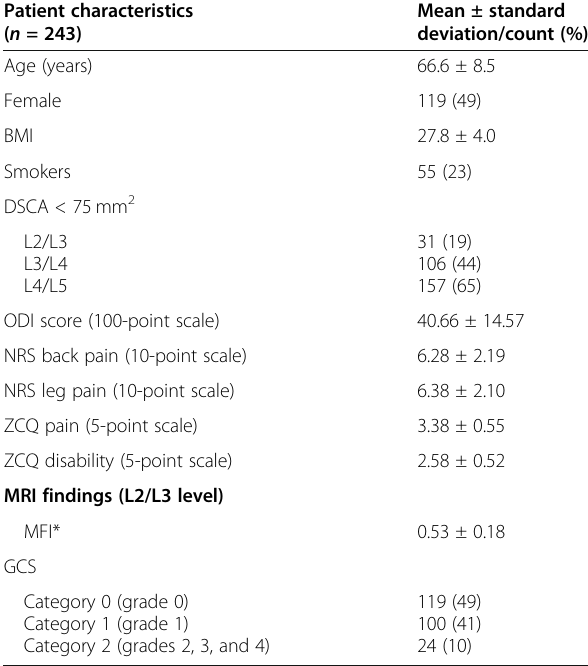
Table 2 Patient characteristics and distribution of MRI findings Patient characteristics ( n =